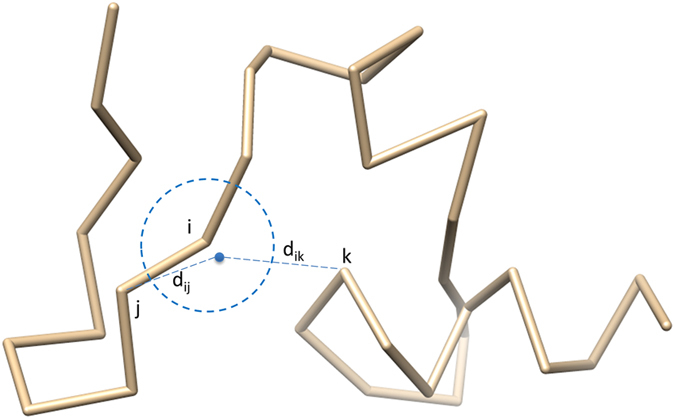
Checking the validity of sampled points.The Euclidean distance of the backbone atom Cα is calculated between the sampled point of the ith residue and each of other residues. The sampled point is accepted if it satisfies the spatial restraints without broken chains (i.e. too far away from adjacent atoms: dij > 4.5 Å) and atom clashes (too close to other atoms: dik < 3.5 Å).